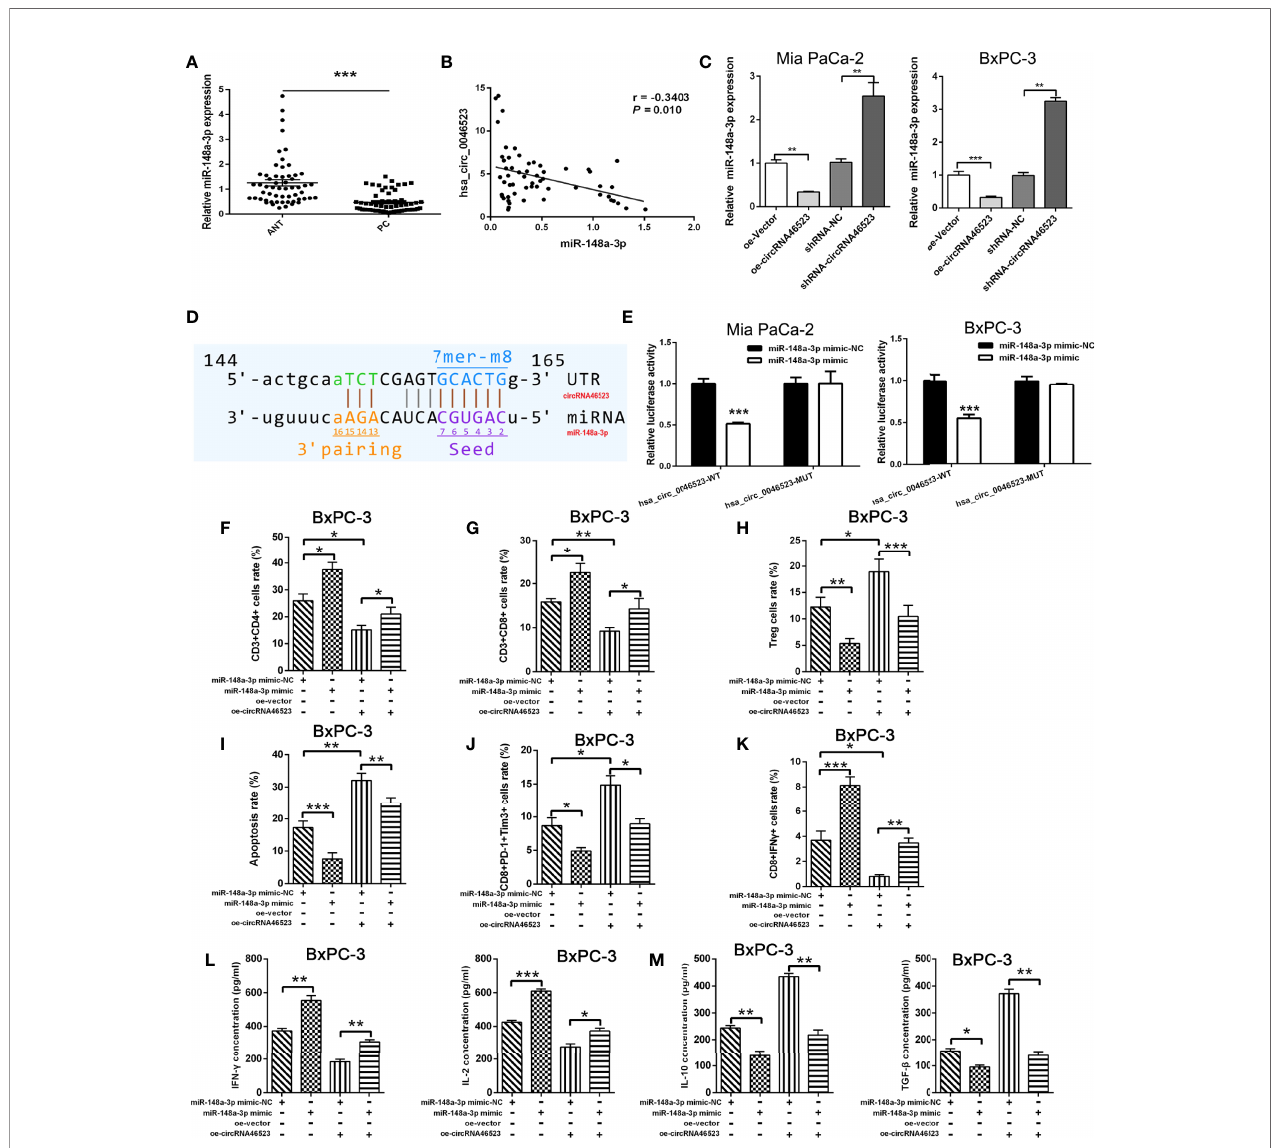
FIGURE 4 | Hsa_circ_0046523 functions as a sponge of miR-148a-3p. (A) qRT-PCR analysis of the expression of miR-148a-3p in 57 pairs of PC and ANT specimens. (B) The expression level of miR-148a-3p is inversely correlated with hsa_circ_0046523 in PC tissues (Pearman ’ s correlation analysis, r =-0.3789, P =0.004). (C) qRT-PCR analysis of miR-148a-3p expression after hsa_circ_0046523 overexpression or knockdown. (D) The targeted binding site of hsa_circ_0046523 and miR-148a-3p. (E) Luciferase activities of hsa_circ_0046523-wt and hsa_circ_0046523-mut constructs when transfecting with miR-148a-3p mimic in PC cells. (F – H) PC cells with upregulated miR-148a-3p or combined with overexpressed hsa_circ_0046523 were co-cultured with PBMC cells. Flow cytometry analysis of the proportion of CD4 + , CD8 + T cells and Tregs in PBMCs after co-culture. (I – K) PC cells with upregulated miR-148a-3p or combined with overexpressed hsa_circ_0046523 were co-cultured with PBMC cells. Flow cytometry analysis of apoptosis, exhaustion and function of CD8 + T cells in PBMCs after co-culture. (L, M) PC cells with upregulated miR-148a-3p or combined with overexpressed hsa_circ_0046523 were co-cultured with PBMC cells. ELISA analysis